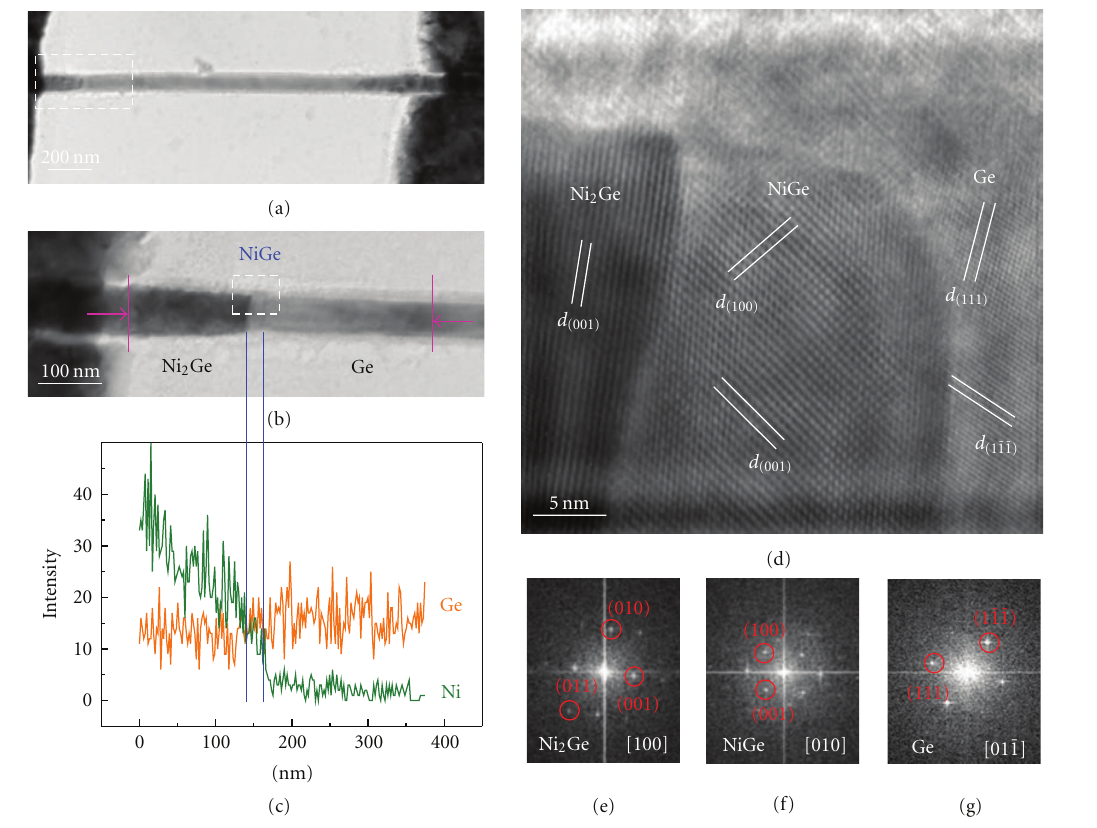
Figure 7: Plane-view TEM images of Ni-Ge nanowire devices on a TEM grid with a 50nm thick Si 3 N 4 window. (a) Low-magnification TEM image of a Ge nanowire reacted with 120 nm thick Ni pads upon 450 ◦ C RTA for 30 s. (b) Enlarged TEM image from the white rectangle in (a). These regions with di ff erent contrasts and compositions are labeled. (c) Corresponding EDS line-scan profiles of Ge and Ni across the region between two red lines in (b). (d) Lattice-resolved TEM image of the formed Ni x Ge/Ge nanowire heterostructure from the white rectangle in (b). The labeled lattice spacings are: d (001) = 0 . 5036 nm for Ni 2 Ge; d (100) = 0 . 538 nm and d (001) = 0 . 5811 nm for NiGe; d (111) = 0 . 3265 nm and d (1-1-1) = 0 . 3265 nm for Ge. (e)–(g) are the FFT patterns taken from the Ni 2 Ge, NiGe, and Ge regions in (d), respectively. Reproduced from